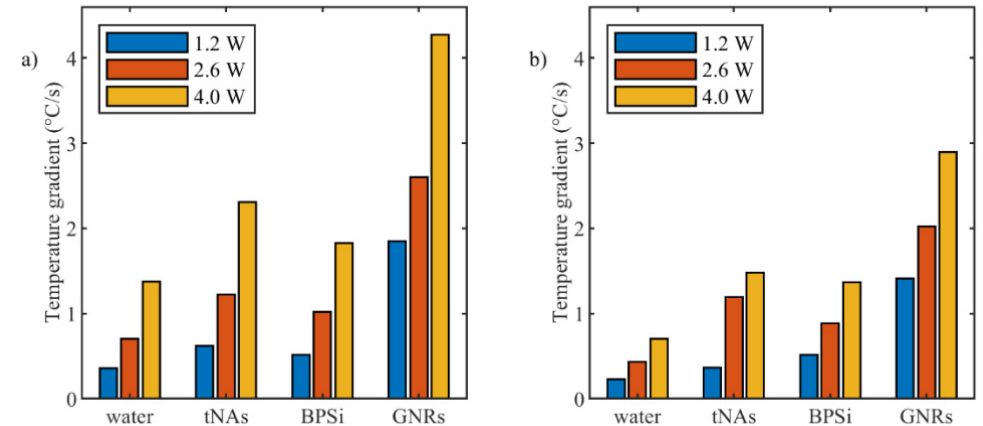
Figure 4. Temperature increase gradient during initial 15 s after starting of irradiation for different power levels measured by ( a ) FBG sensor and ( b ) thermographic camera.